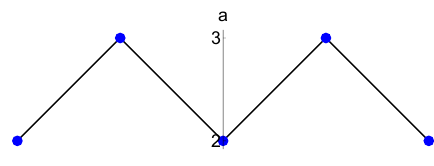
Figure 3 . Homological diagram for 5 1